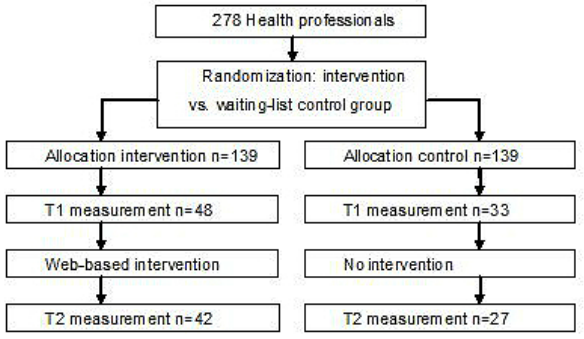
Figure 1. Intervention flow